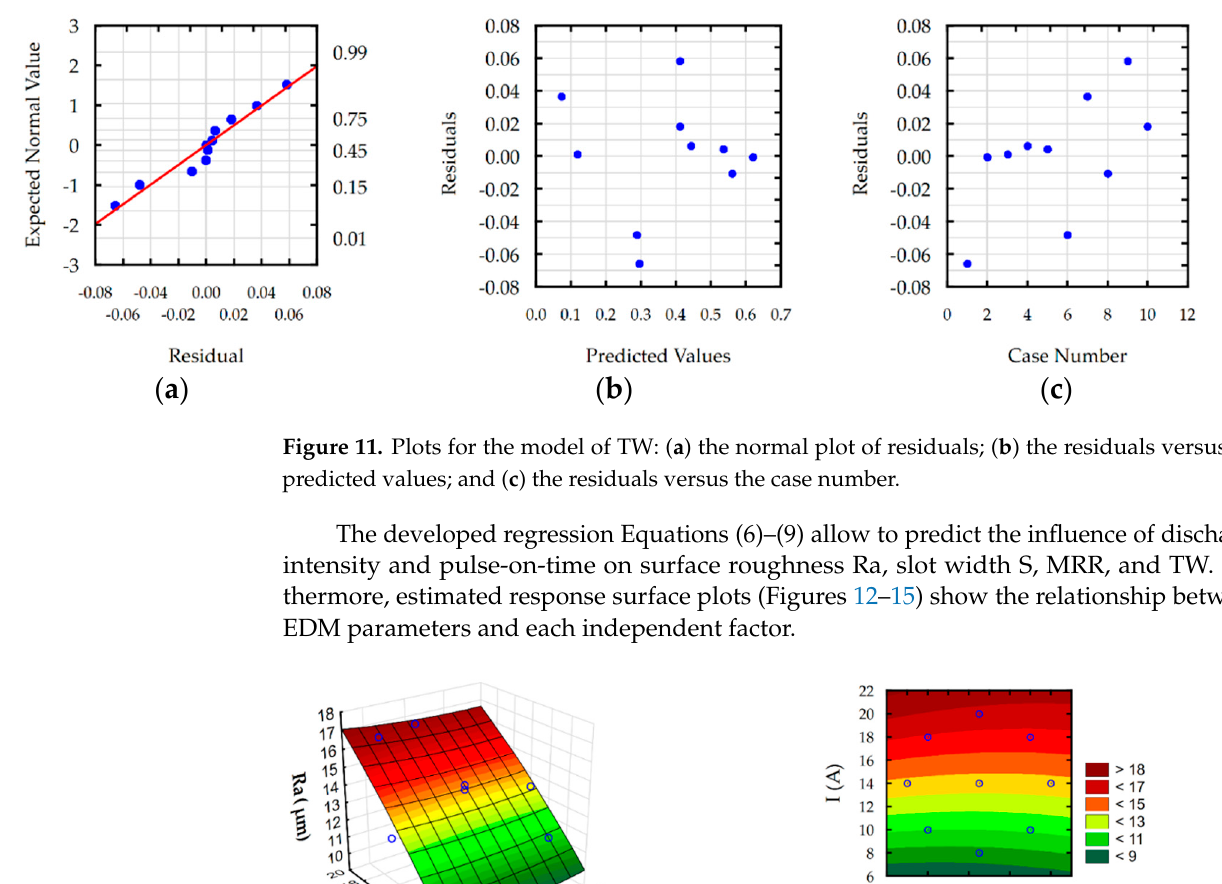
Figure 13. Estimated for slot width S: ( a ) response surface and ( b ) contour plot.